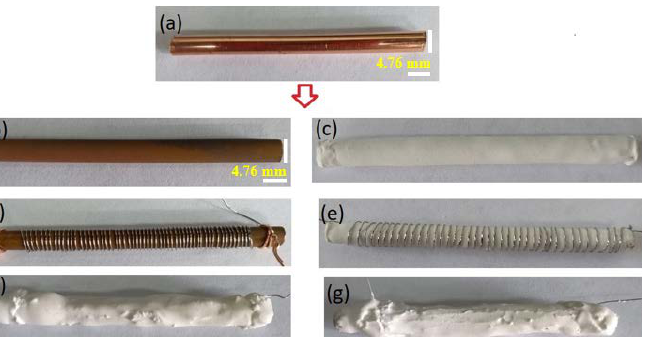
coating): ( a ) the unoxidized copper tube precursor material; ( b ) the copper tube covered with